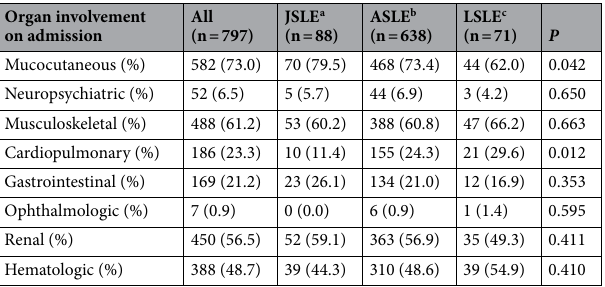
Table 3. Organ involvement among different age-onset groups. a JSLE juvenile-onset SLE; b ASLE adult-onset SLE; c LSLE late-onset